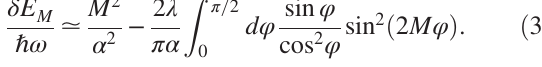
J (shown in the inset)